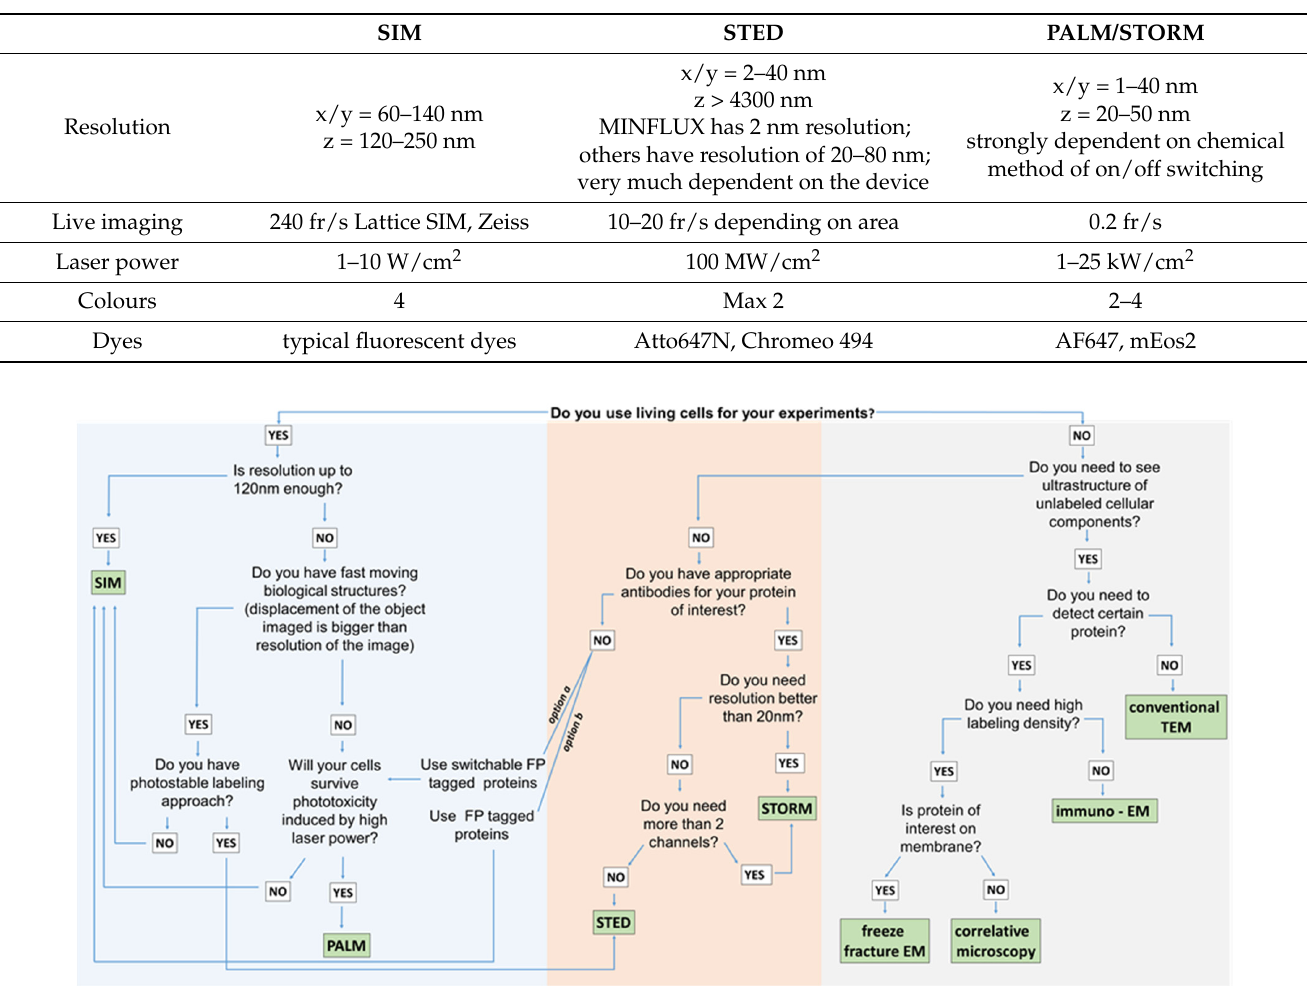
Table 2. Comparison of technical performances of most commonly used super-resolution methods.